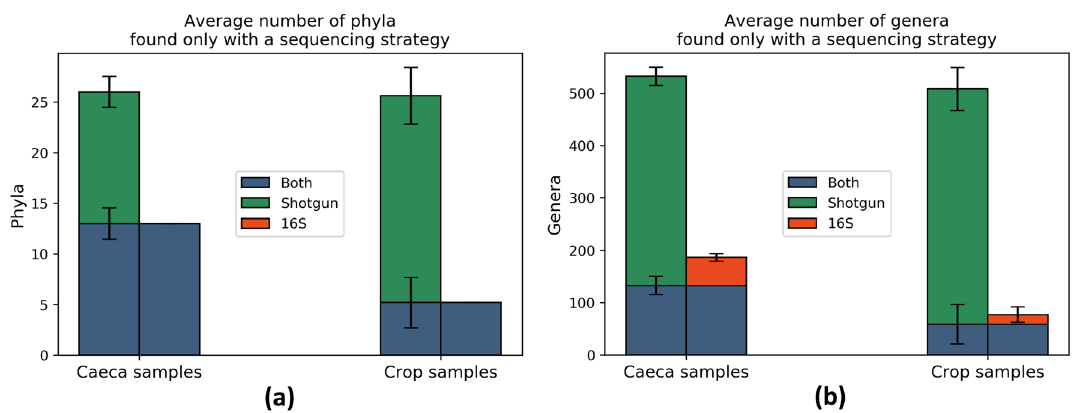
Figure 5. Average number of ( a ) phyla and ( b ) genera found within caeca and crop samples. The length of the error bars is equal to the standard deviation computed on all the